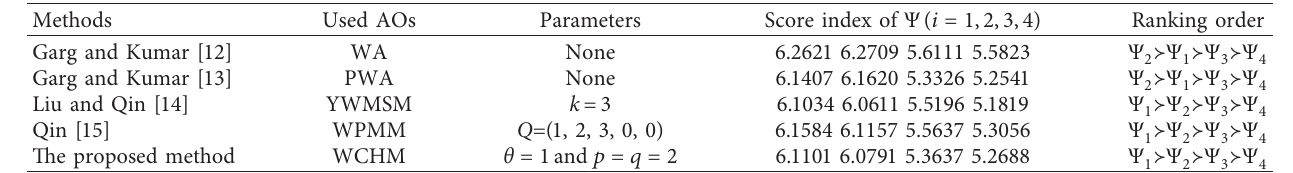
Table 9: Comparison with existing approaches for Example